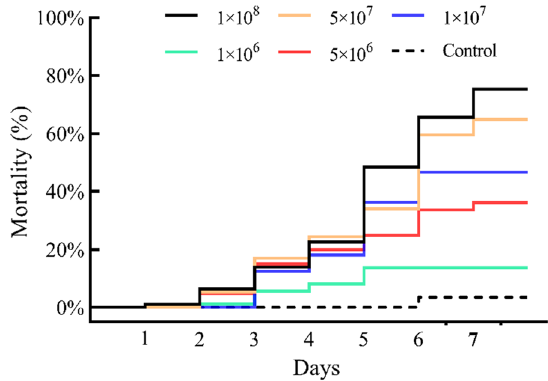
Fig. 3 Observation of adult Diaphorina citri mortality caused by Cladosporium subuliforme wz‑1 isolates with varying conidial concentrations over time. Different colored lines showed different conidia concentrations. The black‑dashed line represented the control (0.05% Tween‑80, v/v)